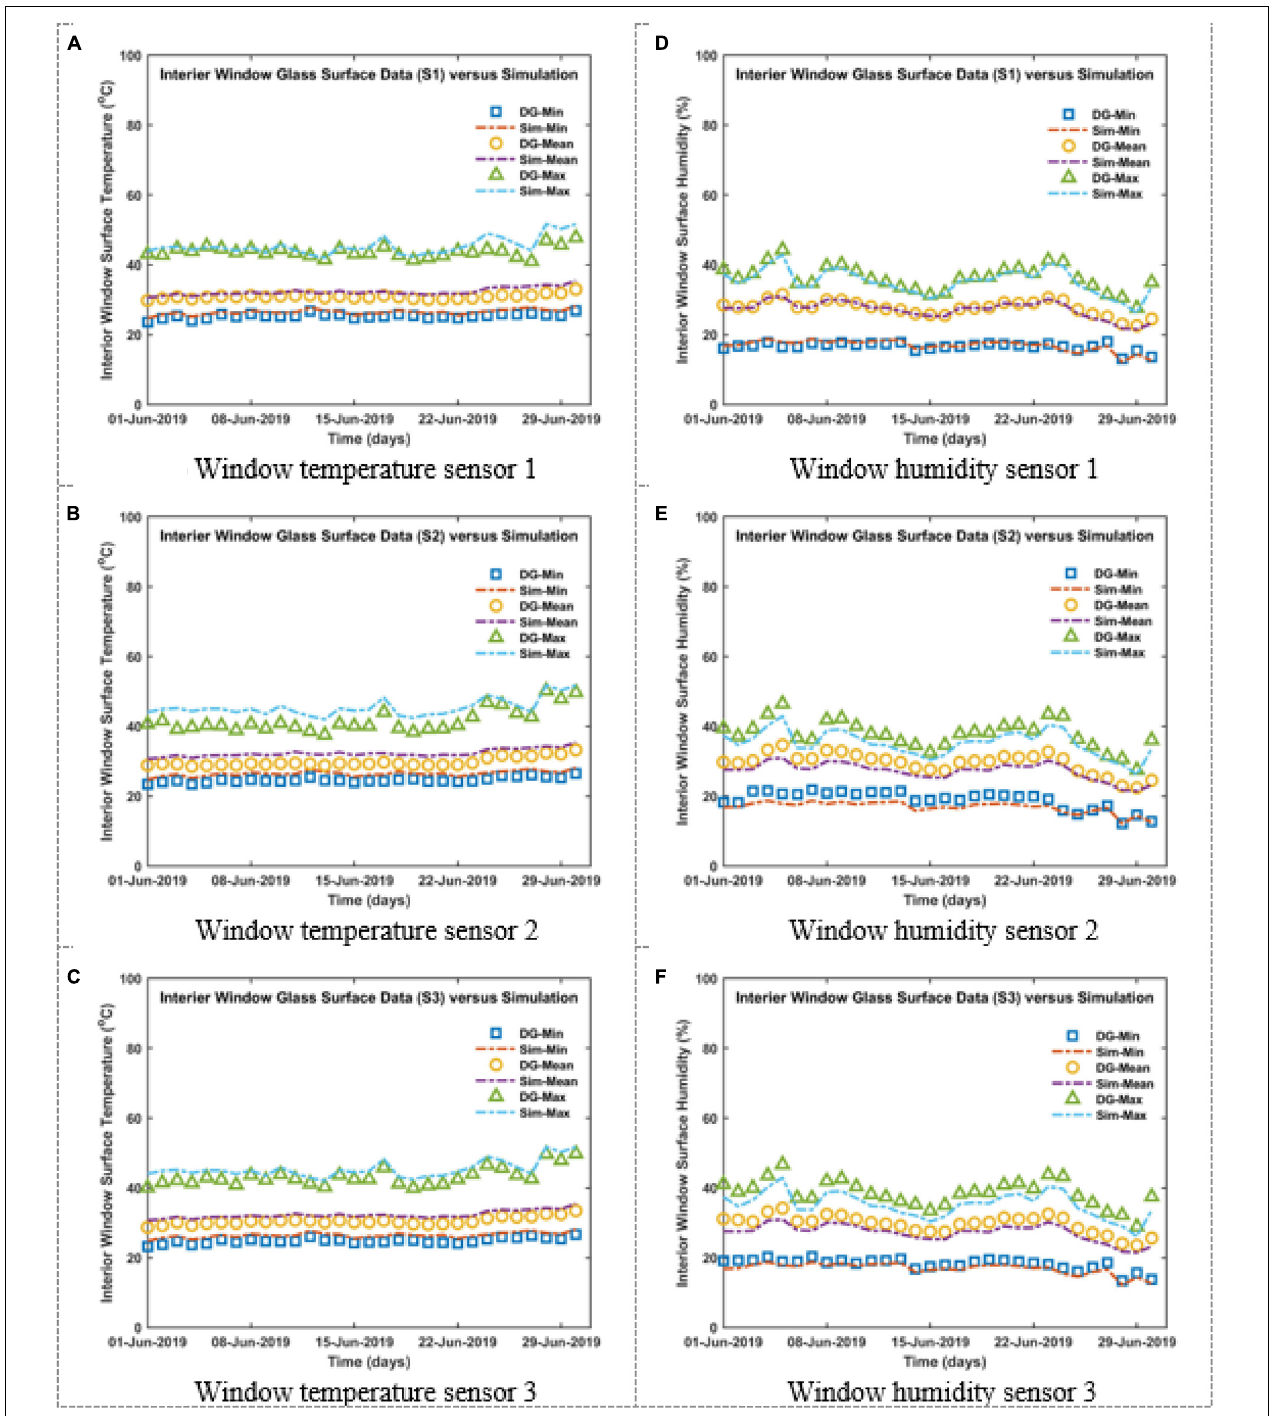
FIGURE 15 | Temperature and humidity (max-mean-min) for three DHT22 sensors on the interior glass surface data versus simulations (Sim) of the offices with double-glazed (DG) windows during the month of June 2019; (A–C) temperatures, and (D–F) humidity variations.